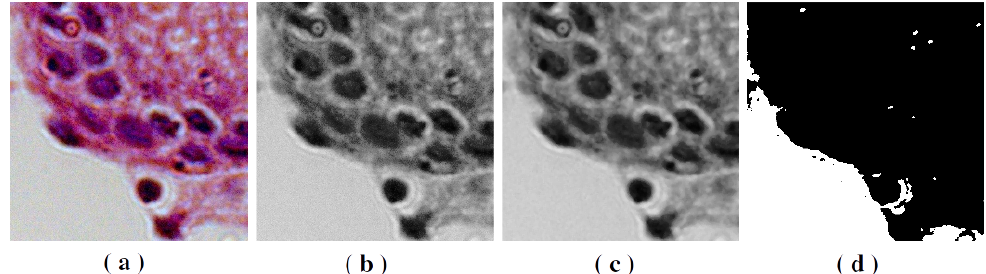
Figure 3. Example image patch filtering process. ( a ) An original patch (256 × 256 pixels); ( b ) patch after grayscale transformation; ( c ) smoothing filter for noise correction; ( d ) gray-scale patch is binarized from the 0–255 spectrum to a 0–1 spectrum.